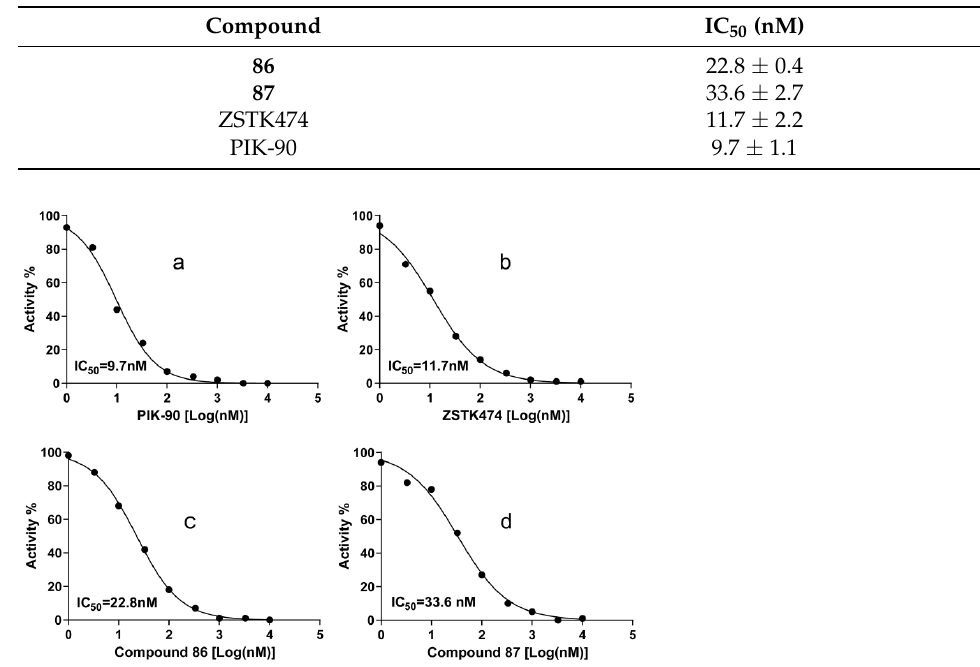
Table 3. IC 50 values of compounds 86 , 87 , PIK-90, and ZSTK474 against PI3K α .